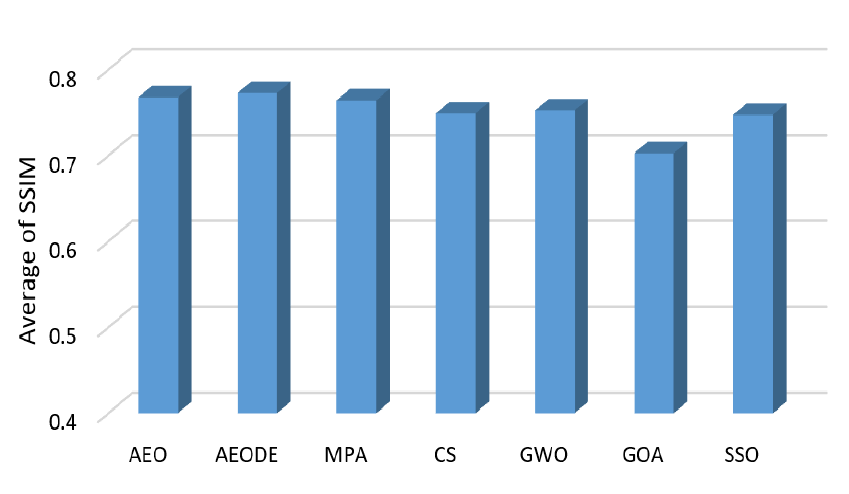
Figure 4. Average SSIM values for all algorithms’ overall images.